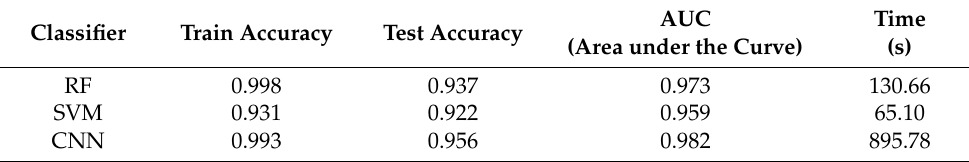
Table 2. Classification performance of the three models.